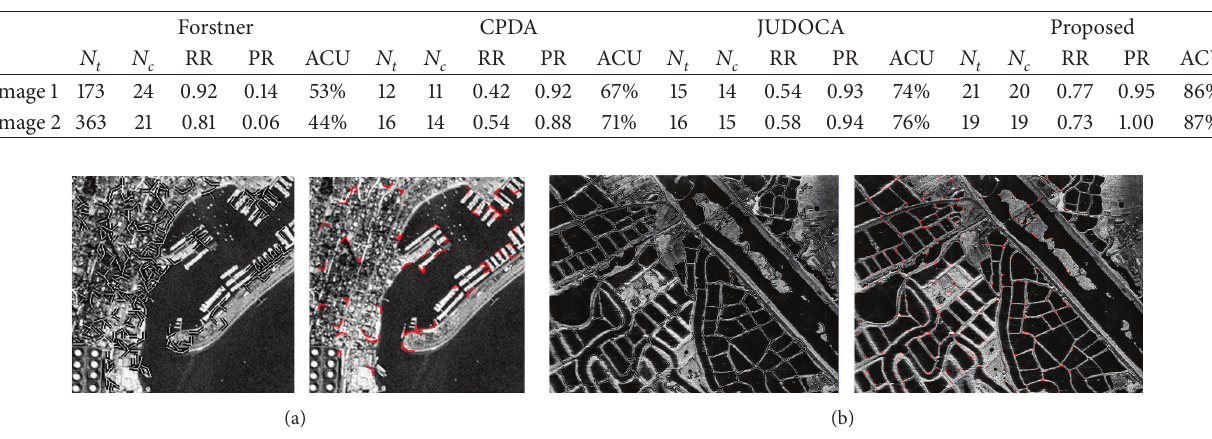
Table 3: Performance of four methods with different levels of noise.